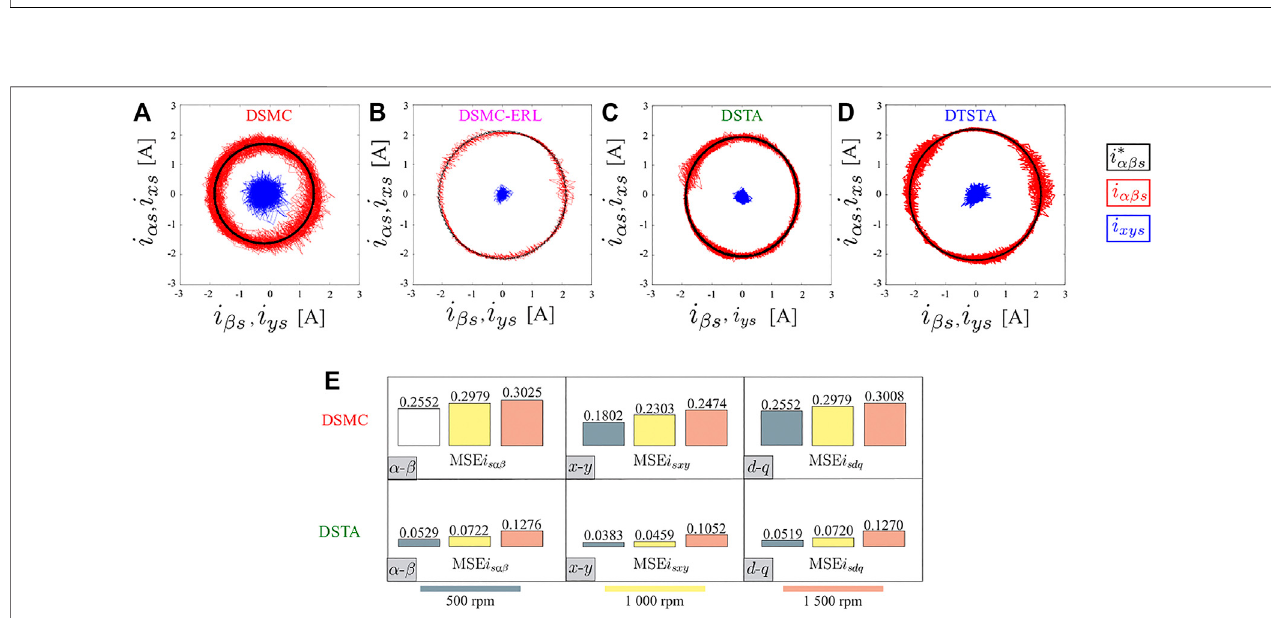
FIGURE 14 | Steady-state analysis: stator α − β and x − y currents in an asymmetrical six-phase IM fed by a dual three-phase VSC (A) Discrete-time Sliding Mode Control (DSMC) (Kali et al., 2019a), (B) DSMC with Exponential Reaching Law (DSMC-ERL) (Kali et al., 2019d), (C) Discrete-time Super-Twisting Algorithm (DSTA) (Kali et al., 2020a) and (D) Discrete-time Terminal Super-Twisting Algorithm (DTSTA) (Kali et al., 2021b). (E) Comparative between DSMC and DSTA using Mean Squared Error (MSE) as performance parameter (Kali et al., 2020a).